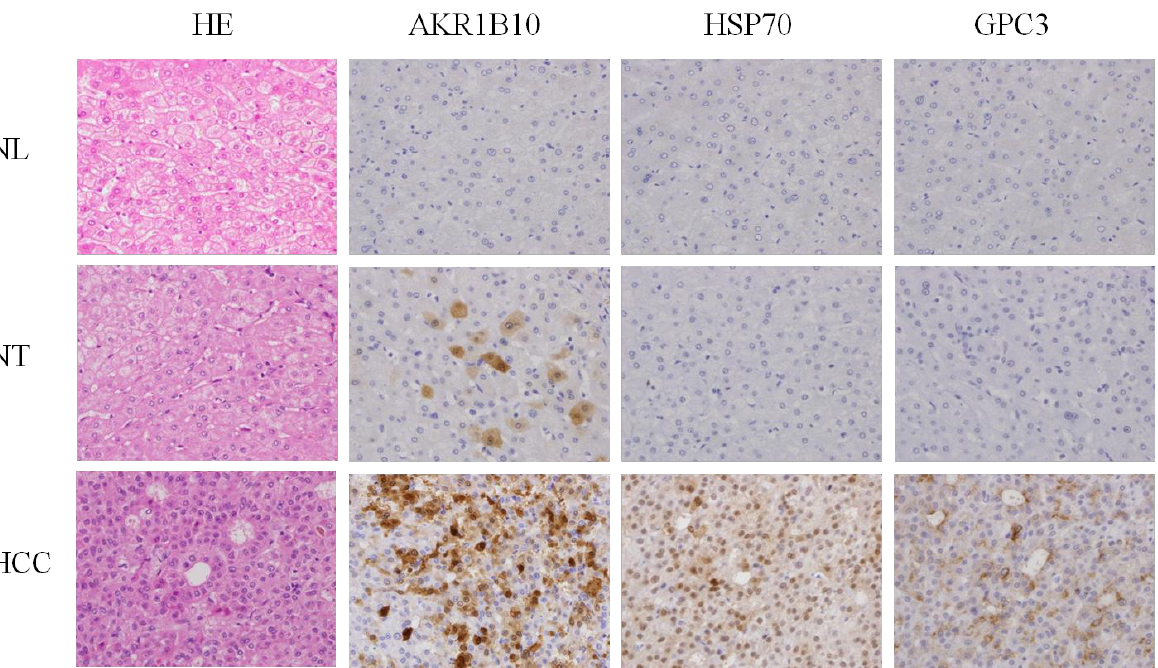
Figure 1. Representative immunostaining of aldo-keto reductase family 1 member B10 (AKR1B10), 70-kilodalton heat shock protein (HSP70), and glypican-3 (GPC3). HCC, hepatocellular carcinoma; HE, hematoxylin-eosin; NL, control normal liver tissue; NT, non-tumorous liver tissue. Original magnification